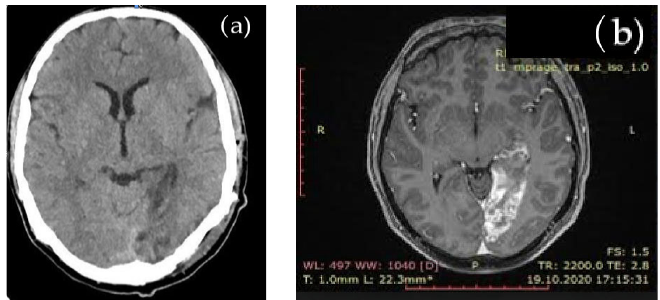
Figure 1. Cerebral imaging: ( a ) native brain CT aspect: left occipital ischemic hypodense lesion; ( b ) brain MRI aspect: left occipital ischemia.